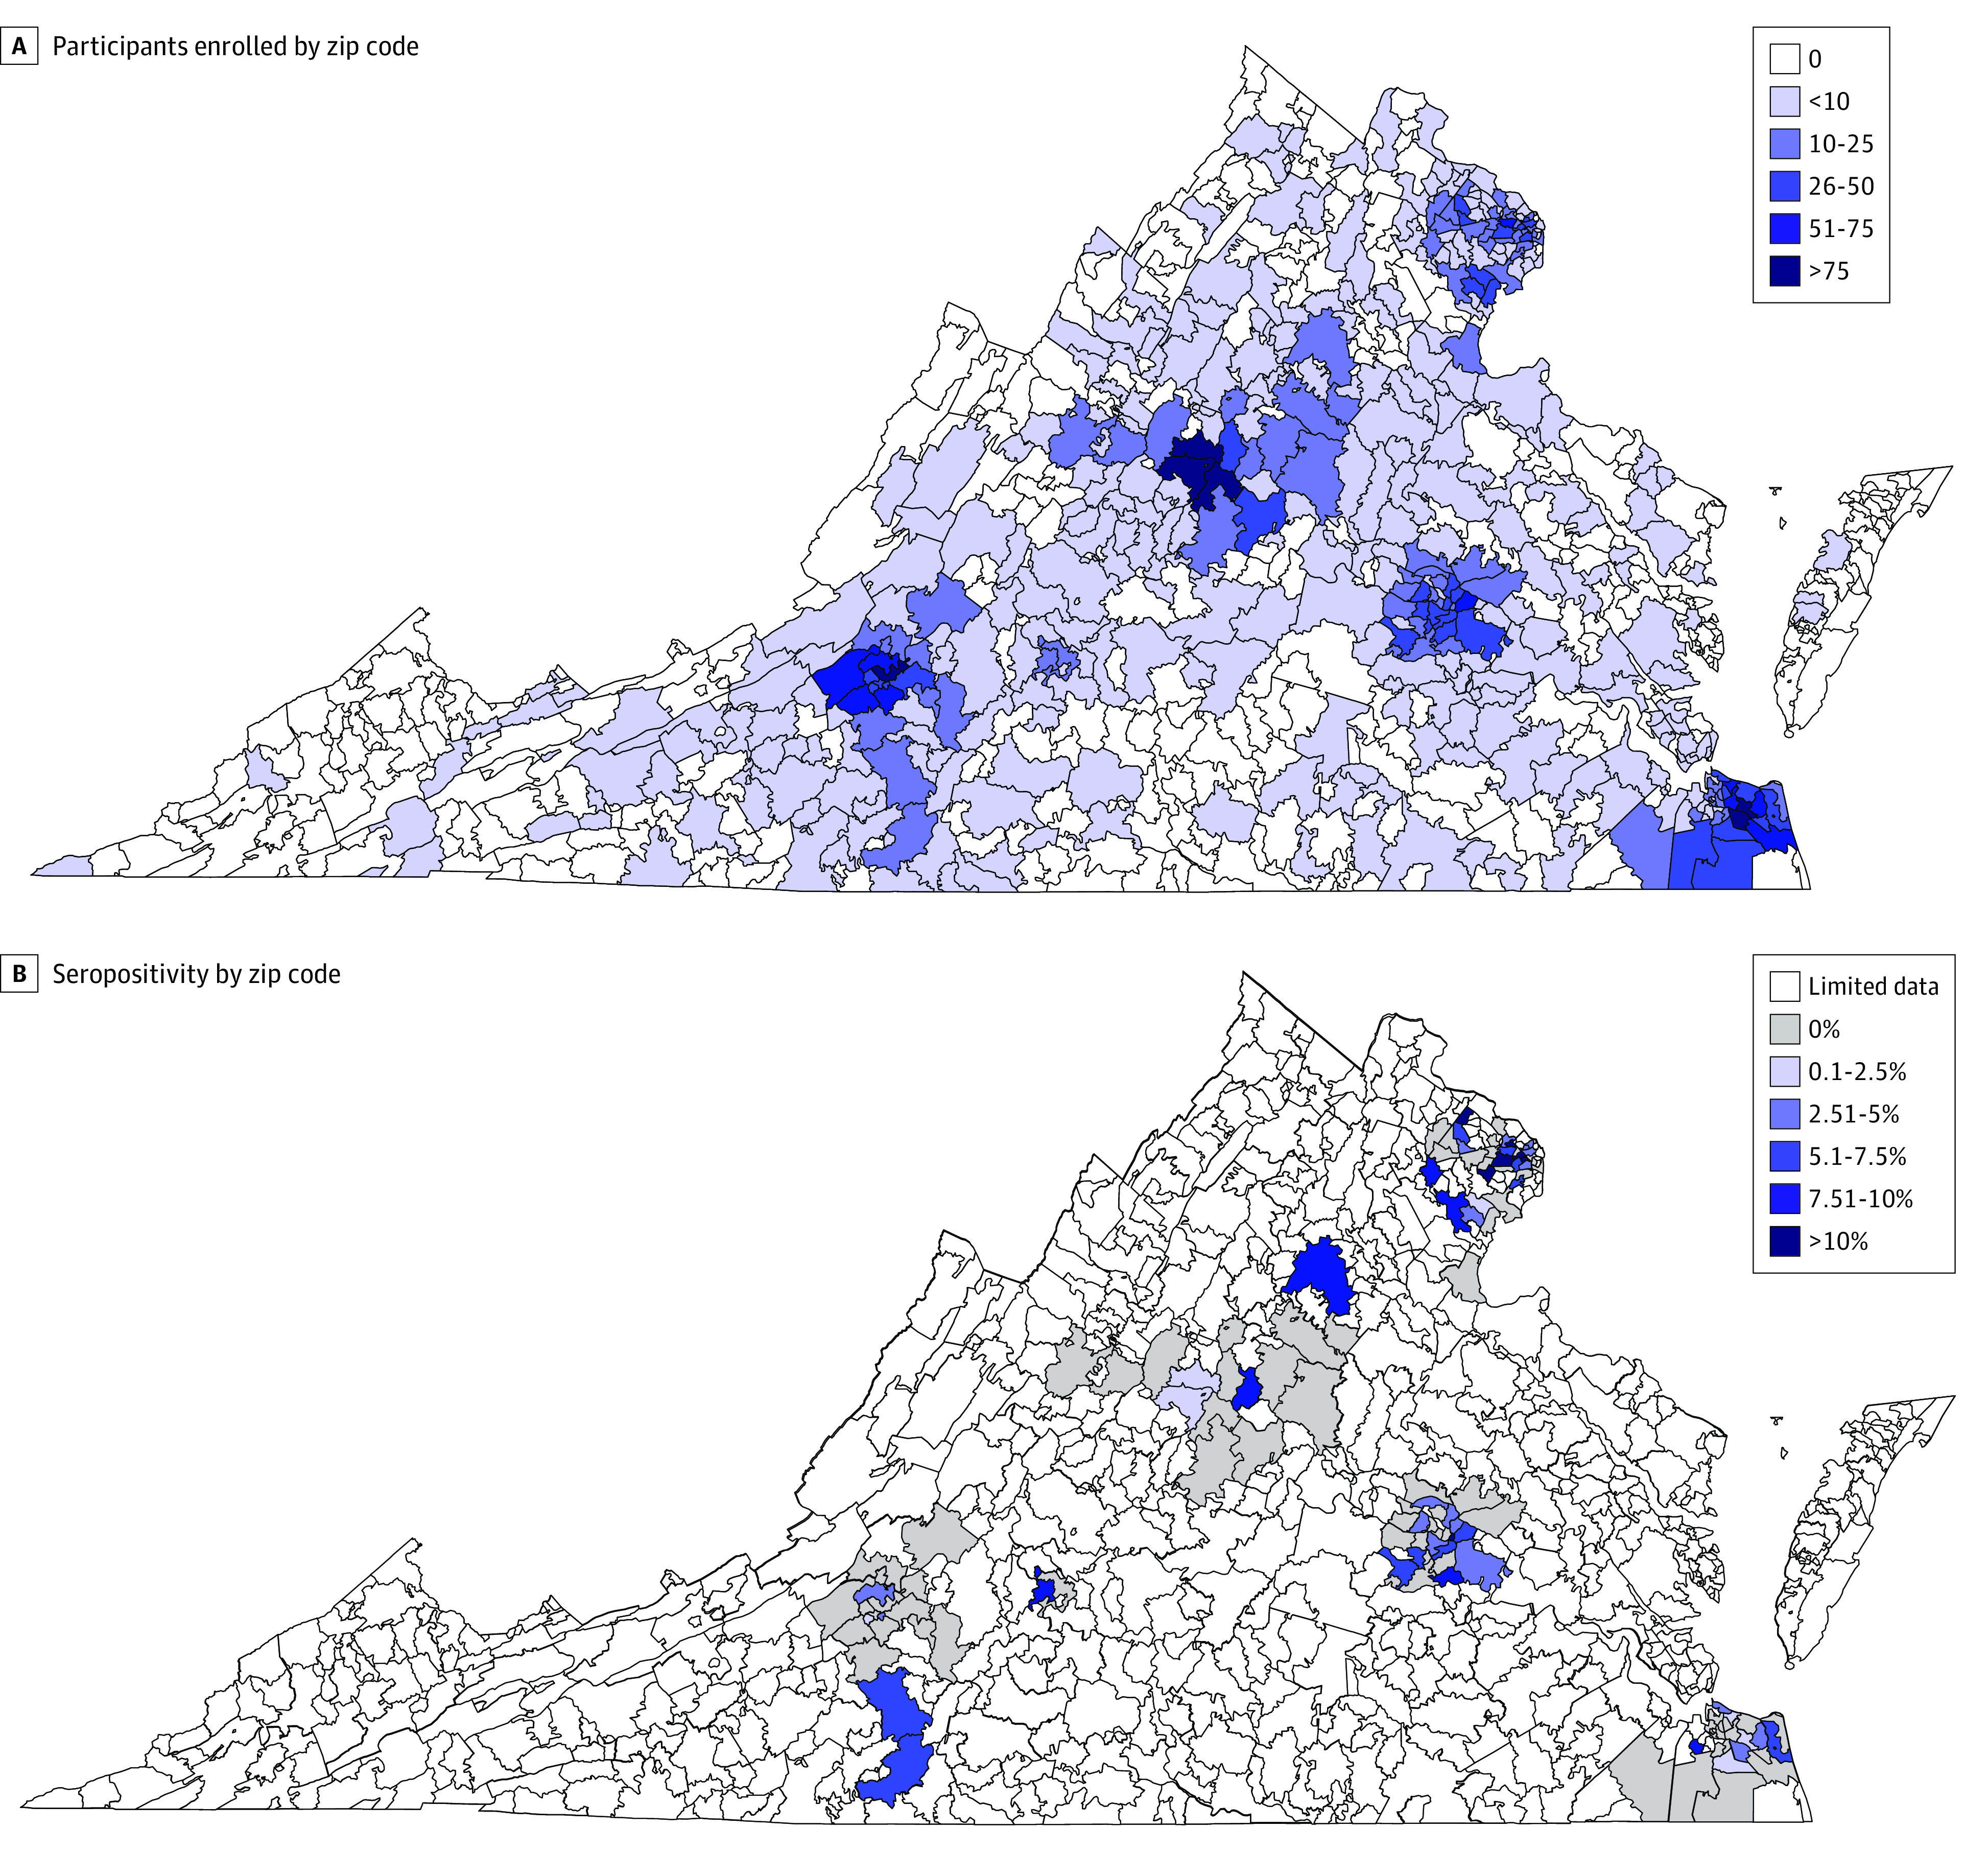
Virginia Coronavirus SeropositivityMaps were created with simplemaps.com. A, Participants enrolled by zip code. Data for any zip code representing a post office were collapsed into the data for the zip code of the post office’s surrounding geographic area. B, Seropositivity by zip code. Only zip codes with at least 10 participants are shown.